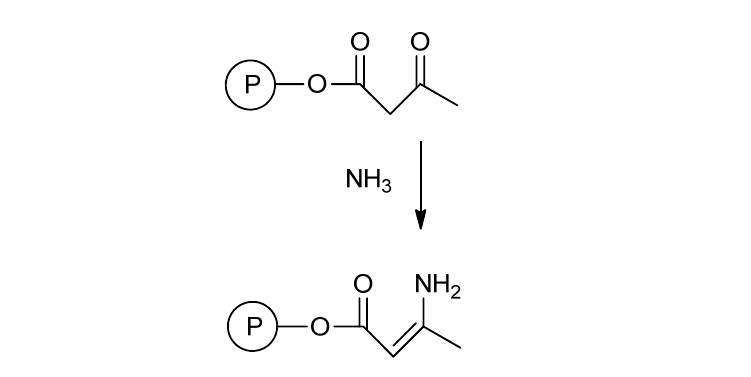
Figure 1. Schematic illustration of enamine formation upon reaction of a β -ketoester functional group with